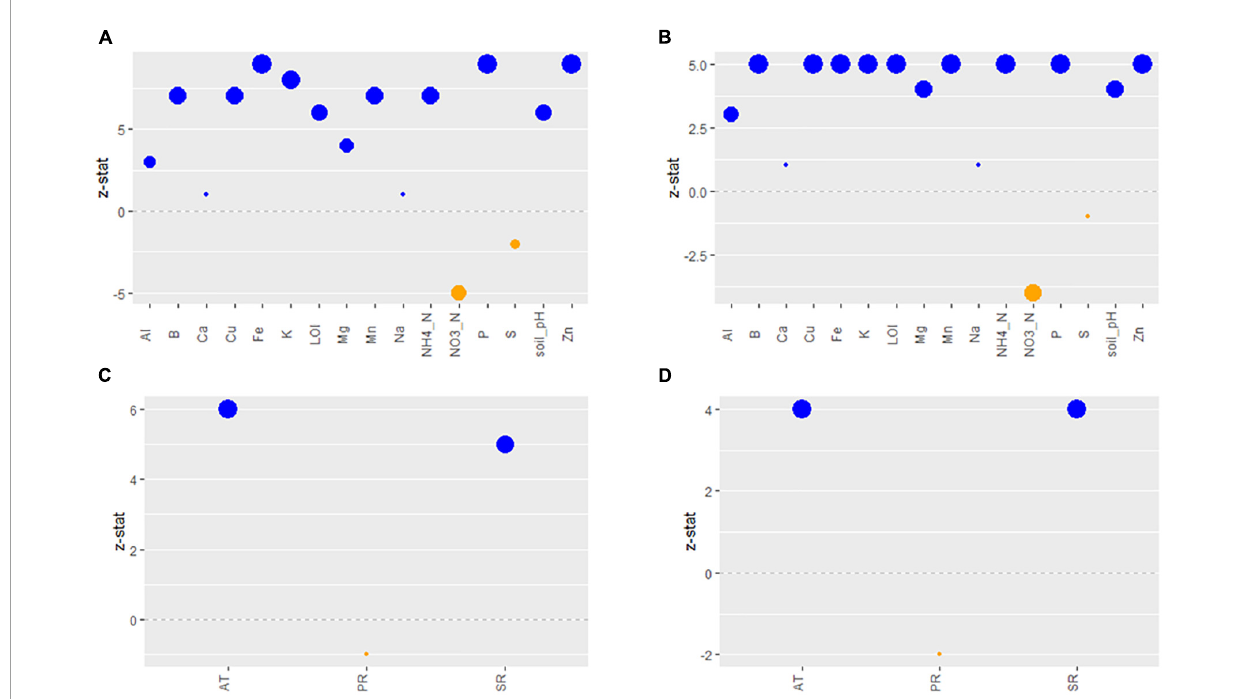
FIGURE4 Effect sizes (z-statistic) of the observed soil chemistry variables composing the predicted (standardized) soil fertility latent variable for the Lm (A) and Arcobacter (B) models. Effect sizes (z-statistic) of the observed weather variables composing the predicted (standardized) Weather latent variable for the Lm (C) and Arcobacter (D) models. Blue dots are positive effect sizes and orange dots are negative effect sizes. The larger the dot, the larger the effect size, i.e., the more important the indicator. Al, aluminum; B, boron; Ca, calcium; Cu, copper; Fe, iron; K, potassium; Mg, magnesium; Mn, manganese; Na, sodium; P, phosphorus; S, sulfur; Zn, zinc; LOI, loss-on-ignition; AT, 24 h average of air temperature; PR, precipitation; SR, solar